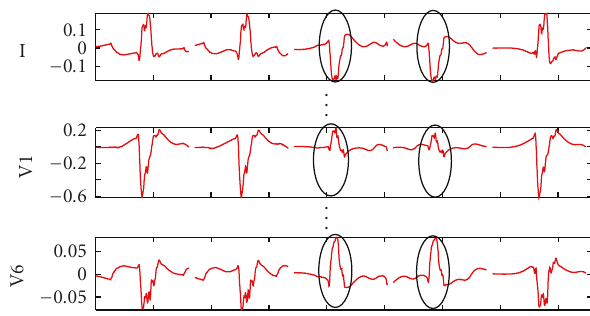
Figure 10: Boxplots of the correlation coe ffi cients, obtained for a patient with sinus rhythm, between ECG and ECGR for each heartbeat and for the 12 ECG channels.